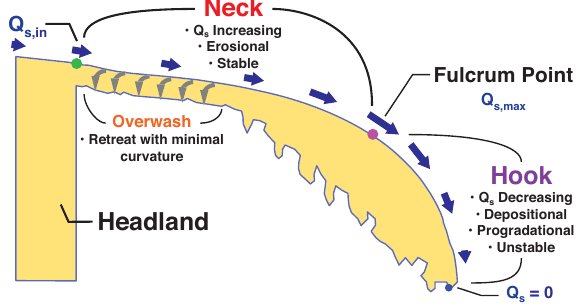
Figure 5. Schematic of key morphologic components of a spit de- fined using alongshore sediment transport